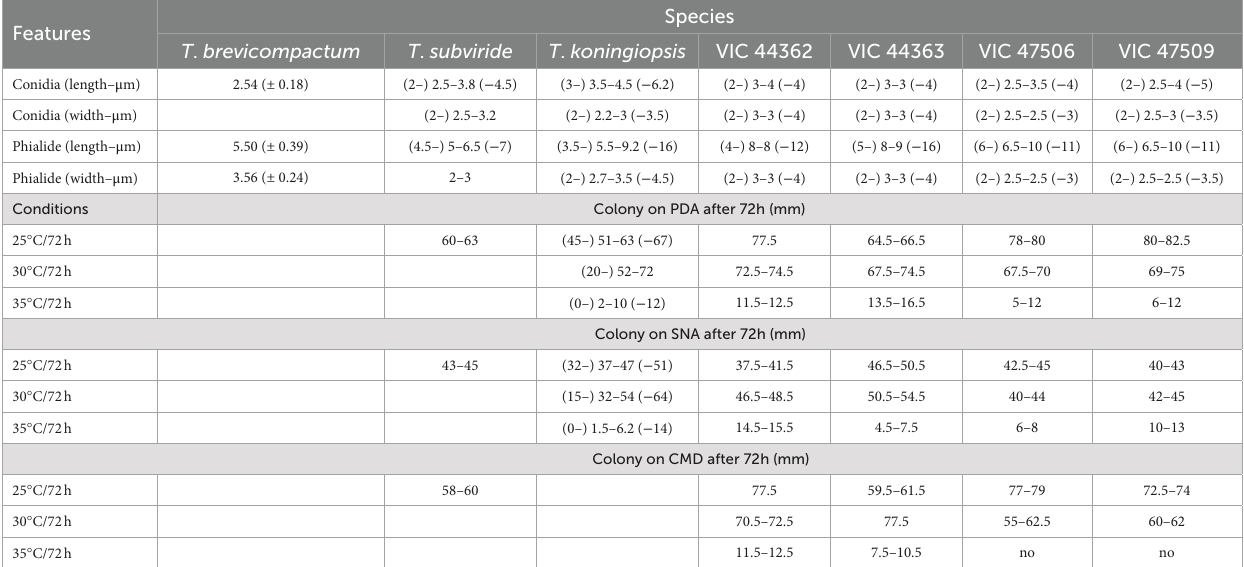
TABLE 3 Morphological differences relevant to the separation of new species of Trichoderma described as endophytes from Hevea spp. from the Amazon Forest.